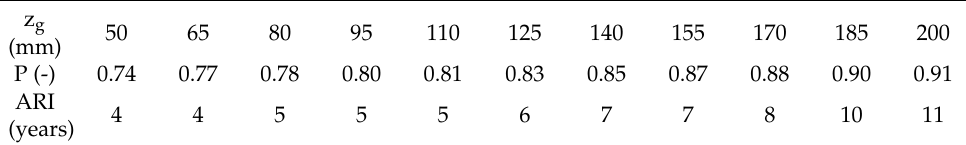
Table 5. Analysis results on the whole period of records, GREEN ROOF 2.